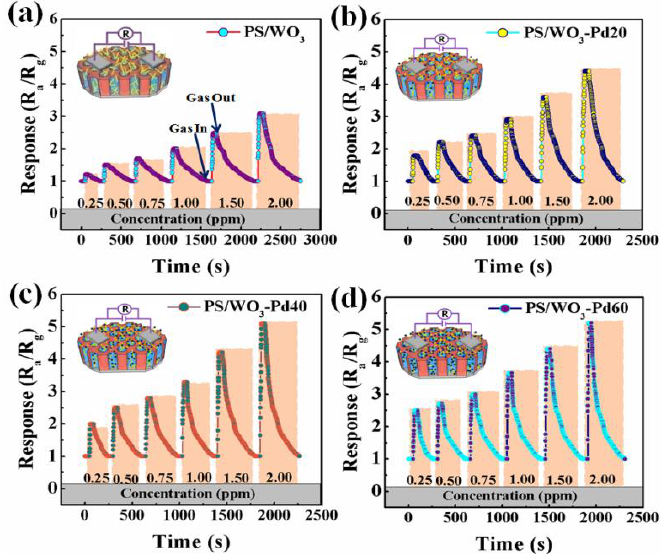
PS/WO 3 – Pd40 sensor; and ( d ) PS/WO 3 –Pd60 sensor to different concentrations of NO 2 with varying times at RT.